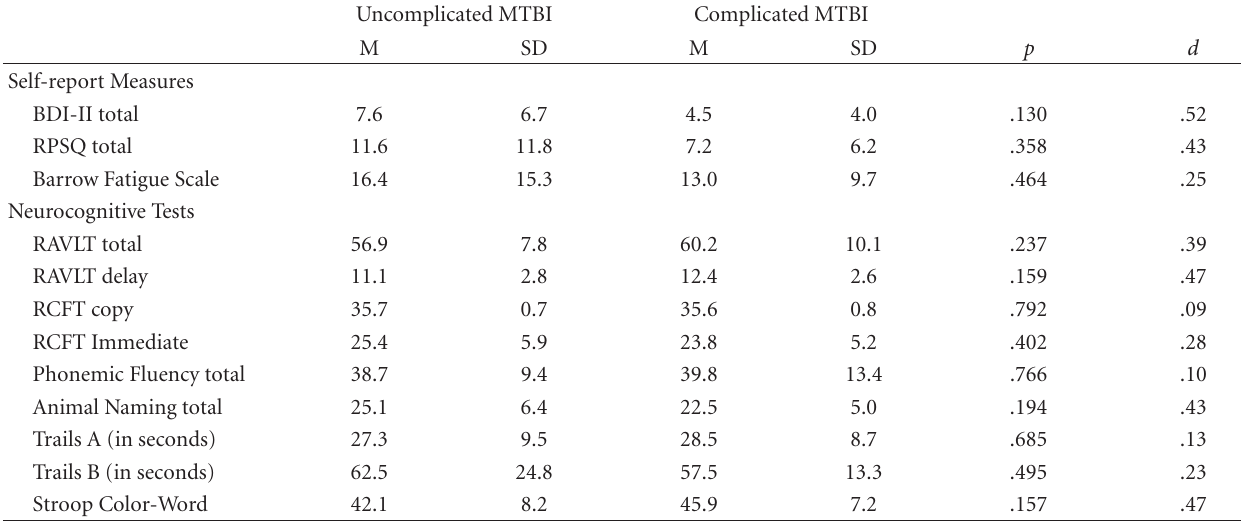
Table 3: Descriptive statistics (raw scores) and e ff ect sizes: self-report and neurocognitive